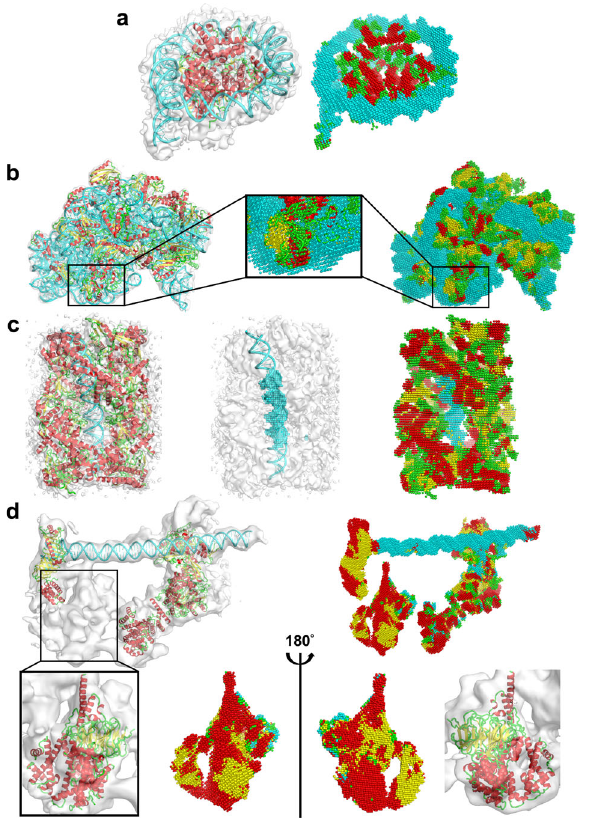
Fig. 5 Examples of structure detection of experimental maps. The density maps and associated structures are shown on the left and the detection results of Emap2sec + are shown on the right. Spheres in red represent detected α helices; yellow, β strands; green, other structures; and cyan, RNA/DNA. Detailed evaluation metrics are shown in Supplementary Data 2. a nucleosome breathing Class 3. EMD-3949; 6ESH 10.2210/ pdb6ESH/pdb. Resolution: 5.10 Å. 738 amino acids (aa) and 274